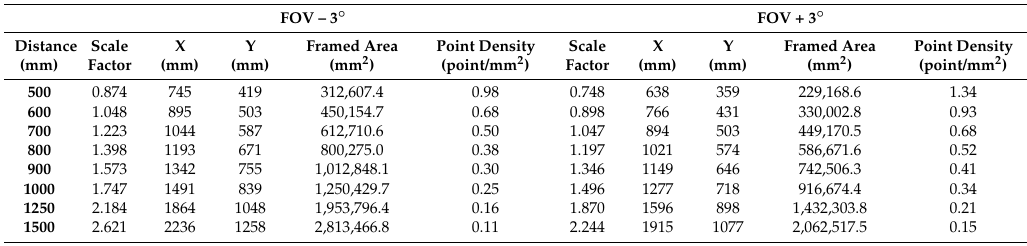
Table 3. The point density and framed area variation at increasing camera–scene distance, computed using maximum and minimum FOV variations (69.4 × 42.5 ◦ +/ − 3 ◦ ).